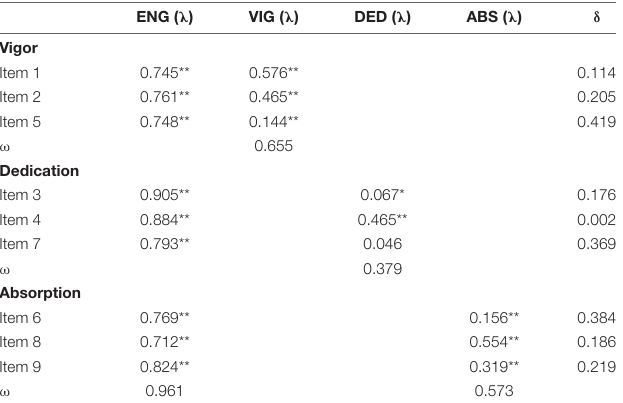
TABLE 2 | Standardized parameter estimates from the latent mean invariant bifactor-CFA solution for the Hungarian version of Utrecht work engagement scale (Model